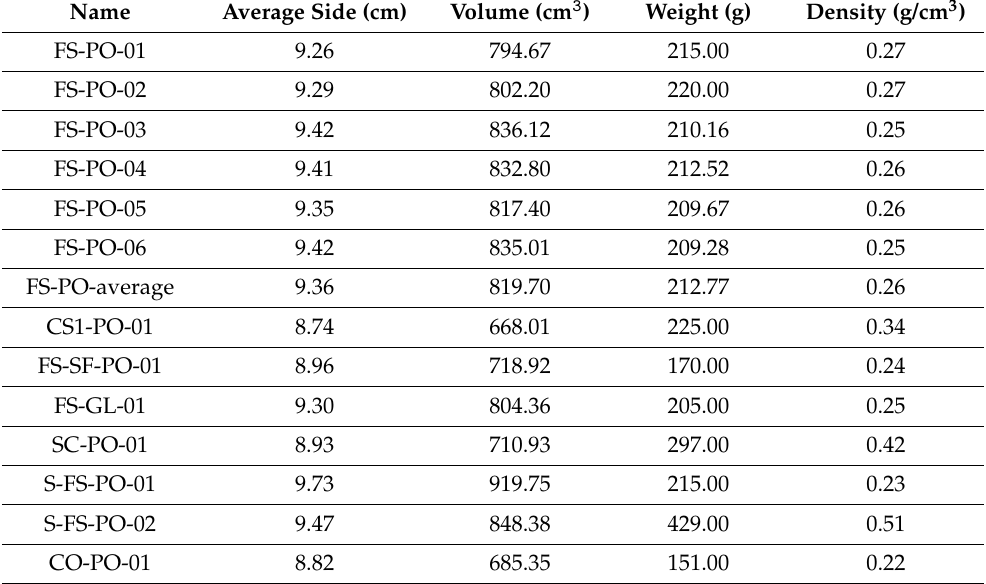
Table 1. Density comparison (density of beech sawdust samples (FS) compared to various samples).